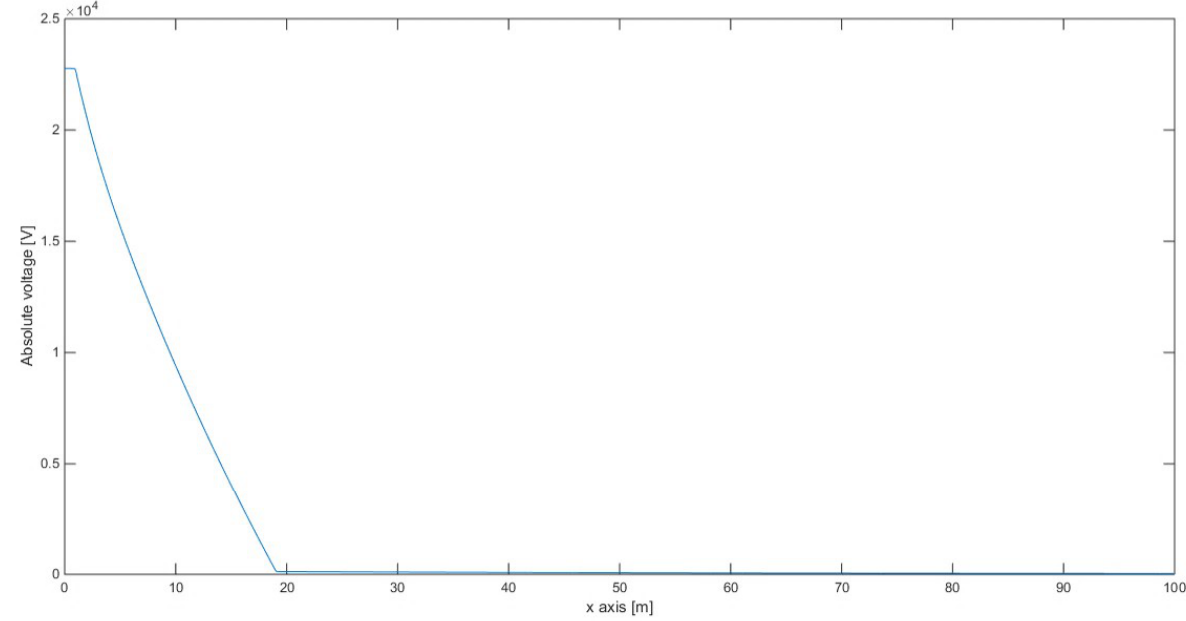
Figure 32. Absolute electric potential on the Ox semi-axis, perpendicular to the perceived axis of the electrode station, at the point of the maximum value of all absolute potentials, applying method “A” for the far field ( ρ S = ∞ ) and method “C” for the near field, with simplifying admissions ( ρ S = ∞ ), with compensation for the presence of a dam; for an electrode station of 6 linear frames in a row, with d frames = 6.50 m, each frame consisted of 13 electrodes of active length L = 2.13 m, D el = 0.50 m, ρ d = 100 Ω · m, ρ w = 0.25 Ω · m, θ w = 2.29 ◦ , θ = 248 ◦ (area of Korakia), J maitenance_steady = 22 A/m 2